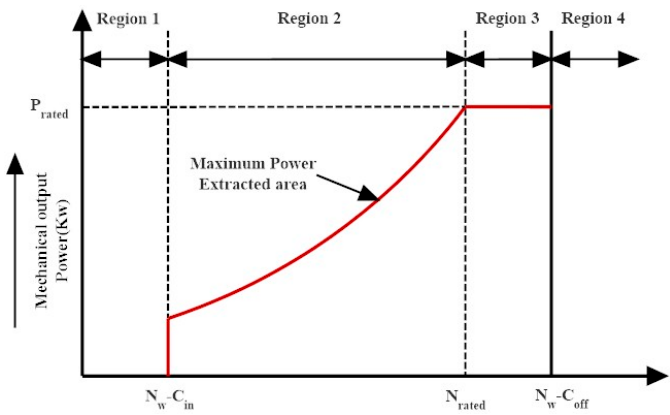
Figure 7. Different operating regions of wind turbines are based on wind velocity.